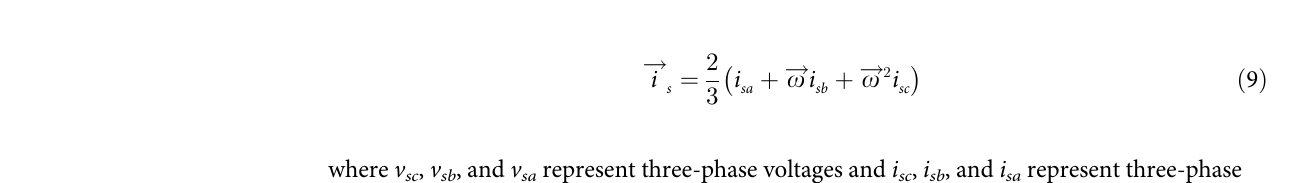
where v currents.